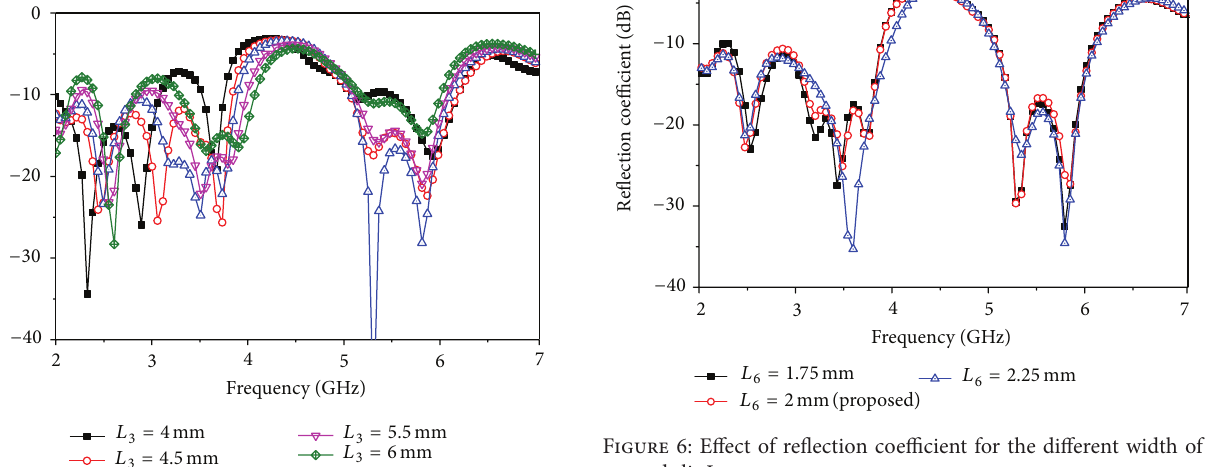
Figure 6: Effect of reflection coefficient for the different width of ground slit 𝐿 6